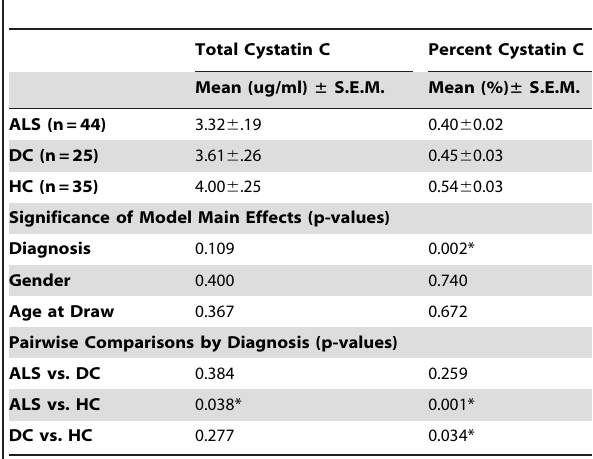
Table 2. CSF main group results for total and percent cystatin